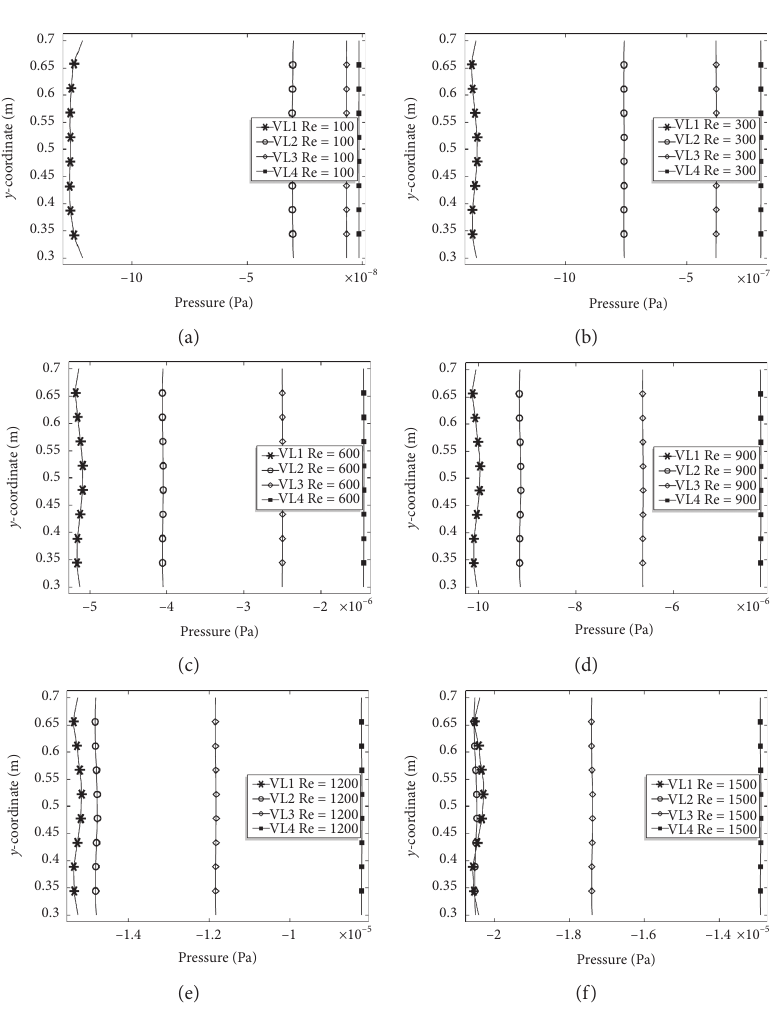
Figure 12: Pressure along vertical